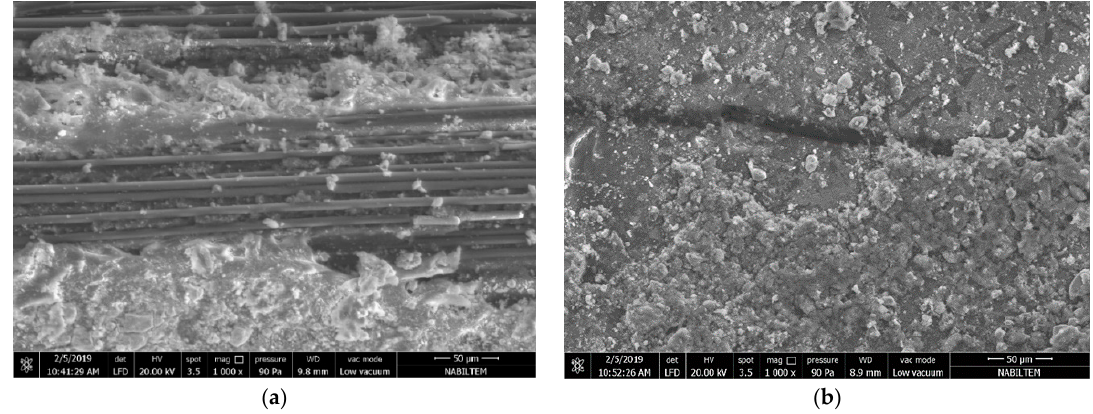
Figure 16. Microstructure view of the M60C composite fibers: ( a ) with peel off; ( b ) without peel off